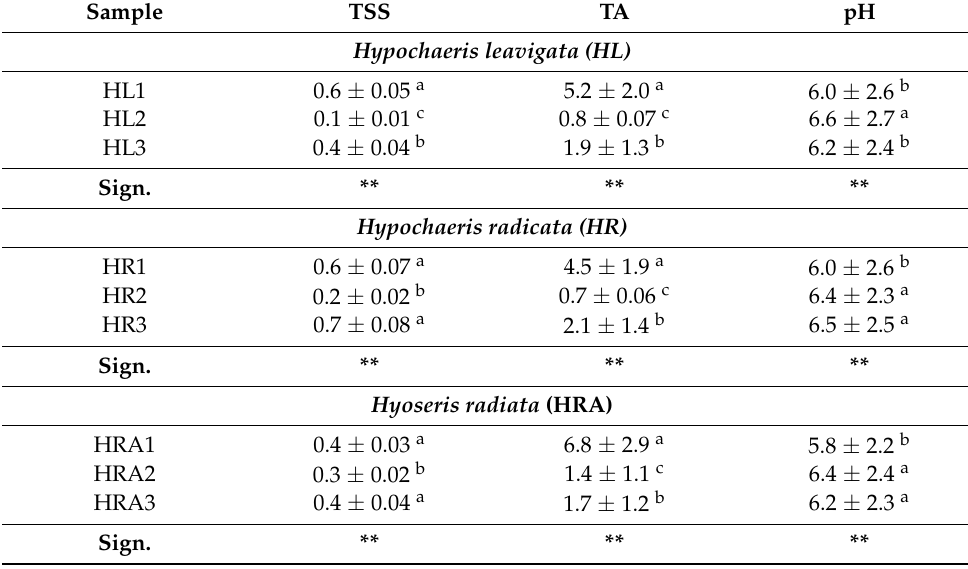
Table 2. Fresh Hypochaeris radicata (HR) and H. laevigata (HL) leaves showed a higher TSS contents than the values obtained in the leaves after blanching and in the blanching water. The same trend was observed in the titratable acidity values. Table 2. Total soluble solid content (TSS), Titratable acidity (TA), and pH of Hypochaeris and Hyoseris